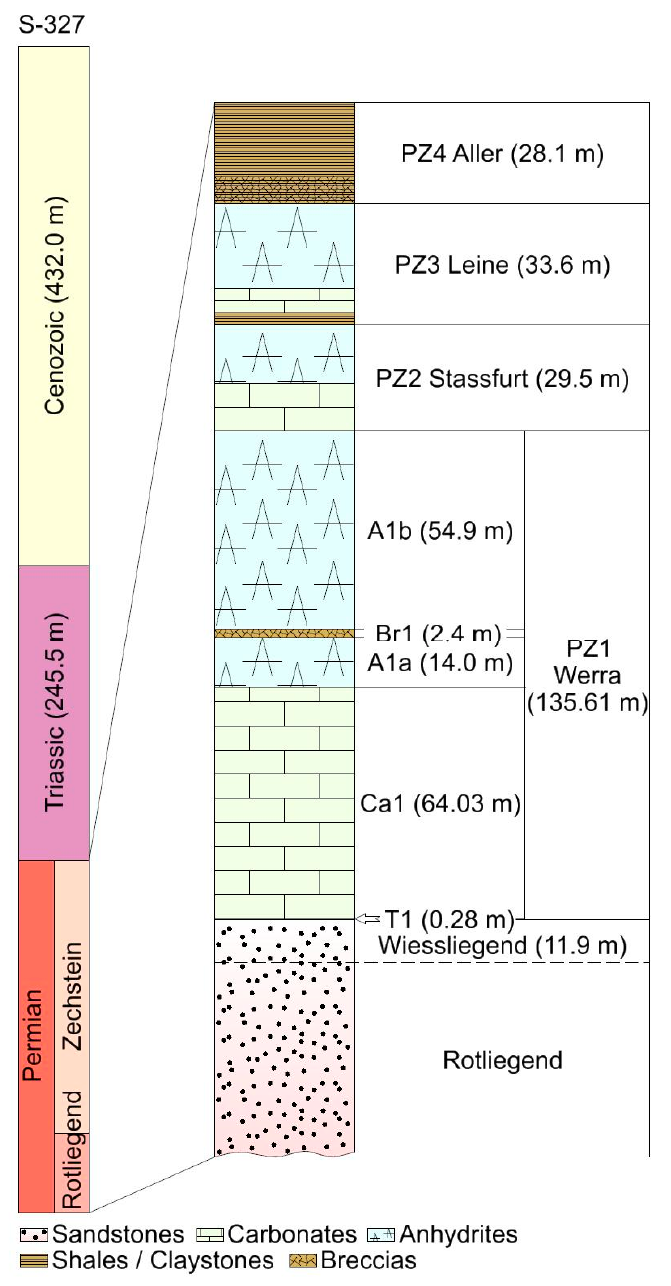
Figure 2. Geostratigraphic profile in the S-327 borehole (T1–Coppershale; Ca1–Zechstein Limestone;